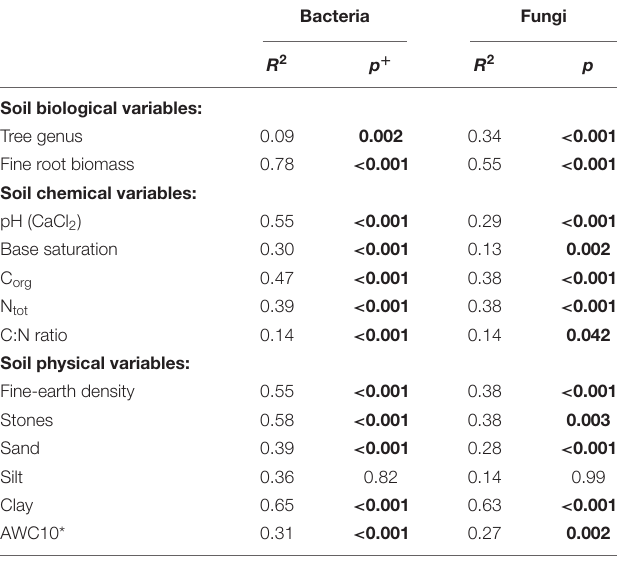
TABLE 6 | Strength of the correlation ( R 2 ) of the soil environmental variables to microbial community dissimilarities in the various soil layers (L1–L6) of beech and oak sites calculated with a non-metric multidimensional scaling (NMDS) ordination of the Bray–Curtis dissimilarity matrix. Bacteria